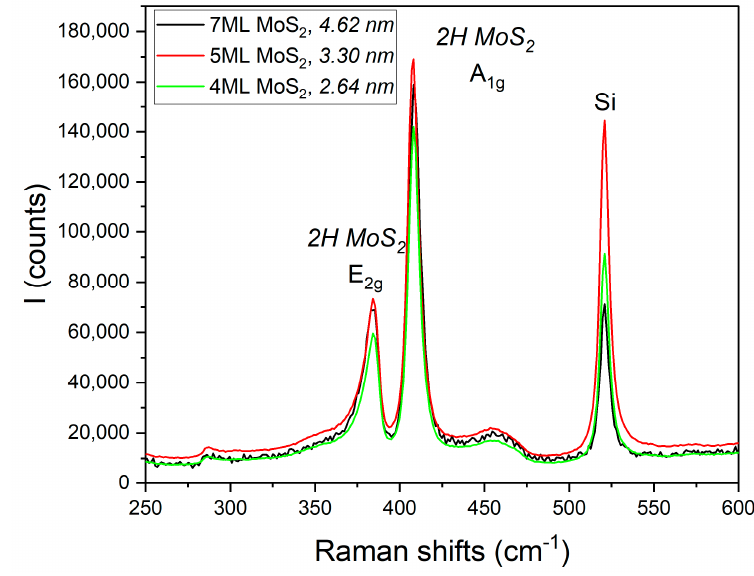
Figure 1. Raman spectra of the three samples with 4, 5, and 7 ML MoS 2 .